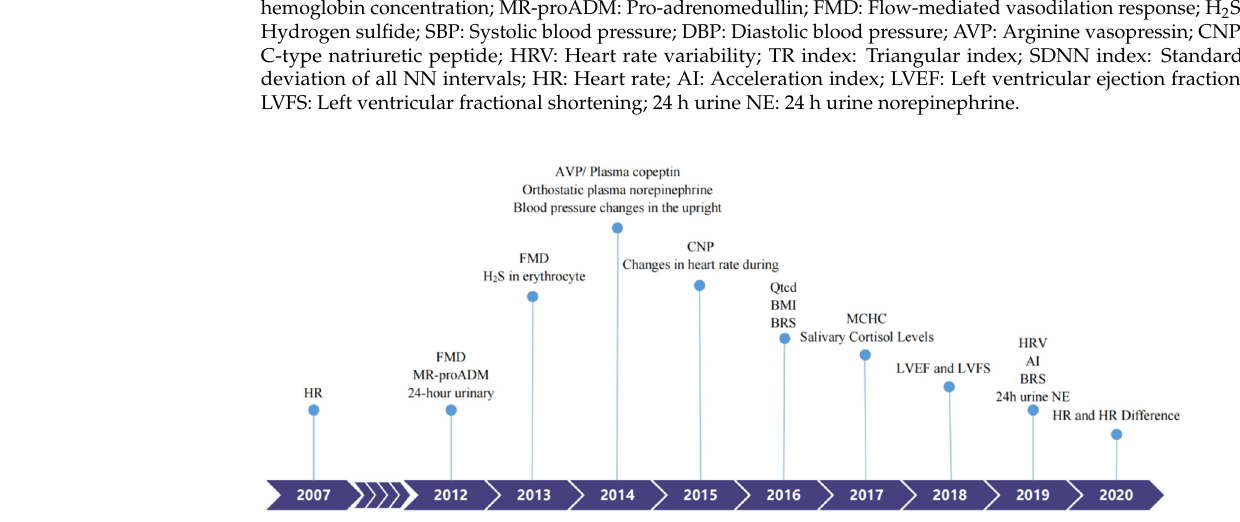
Figure 1. Biomarkers to predict individualized treatment for VVS and POTS in chronological order.